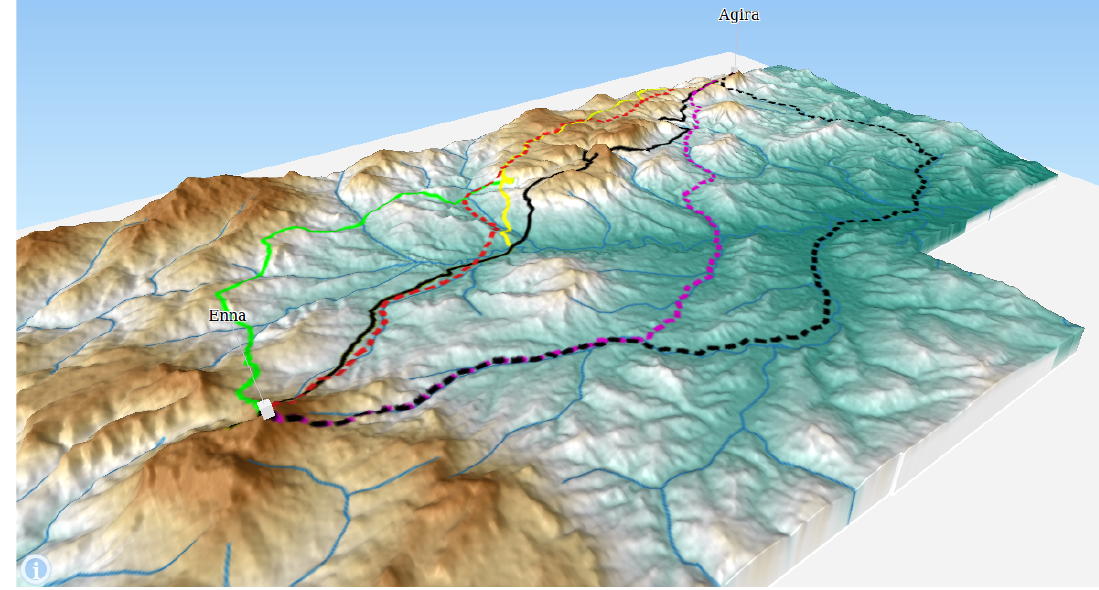
Fig. 5. The same situation in a 2.5D